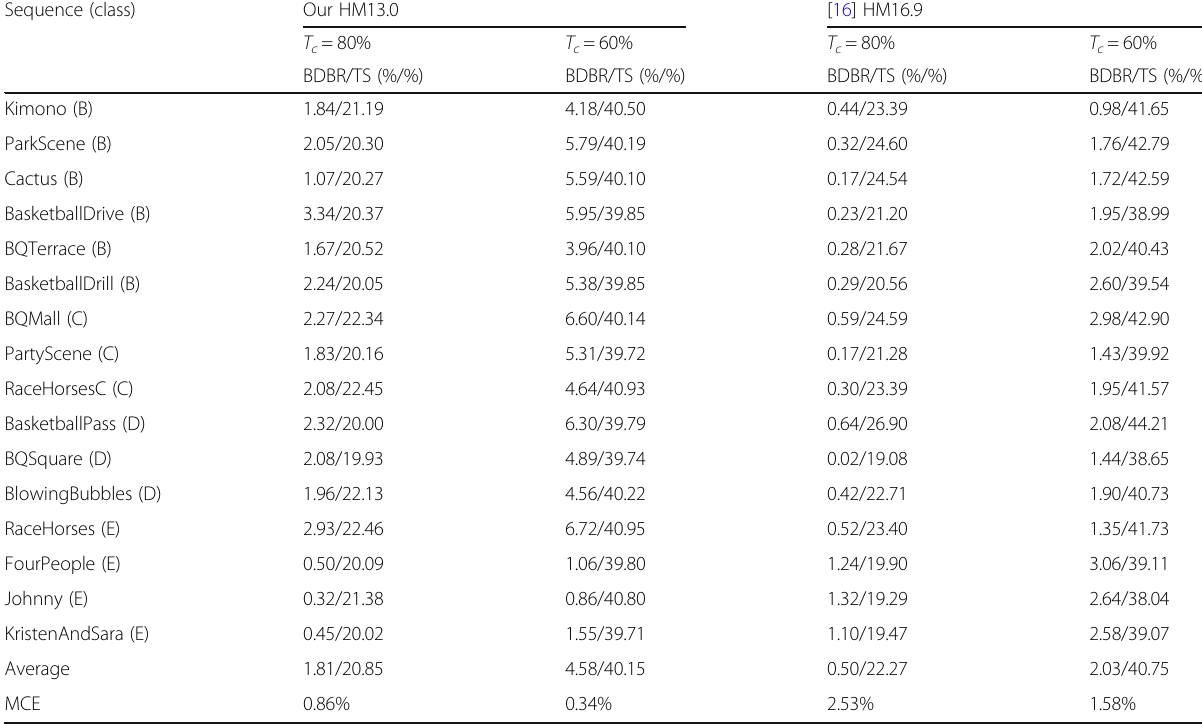
Table 6 Performance comparison between the proposed algorithm and